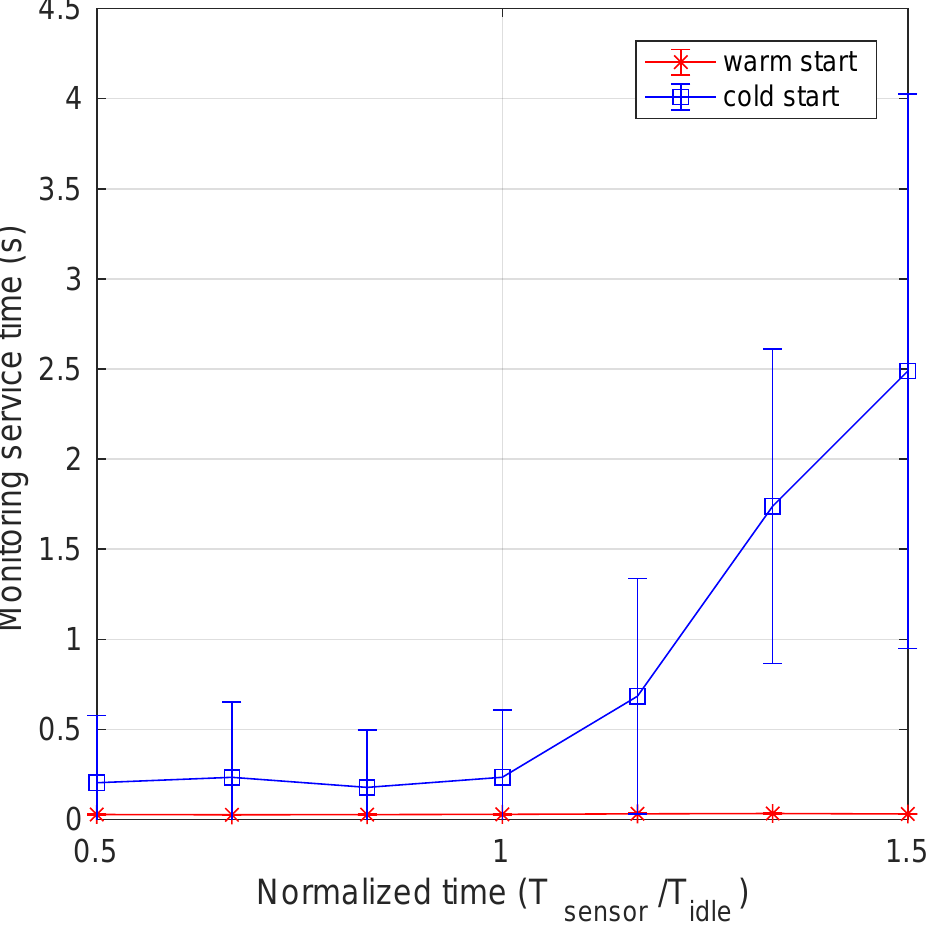
Figure 6. Monitoring time as a function of the normalized transmission period for both cold and warm start.